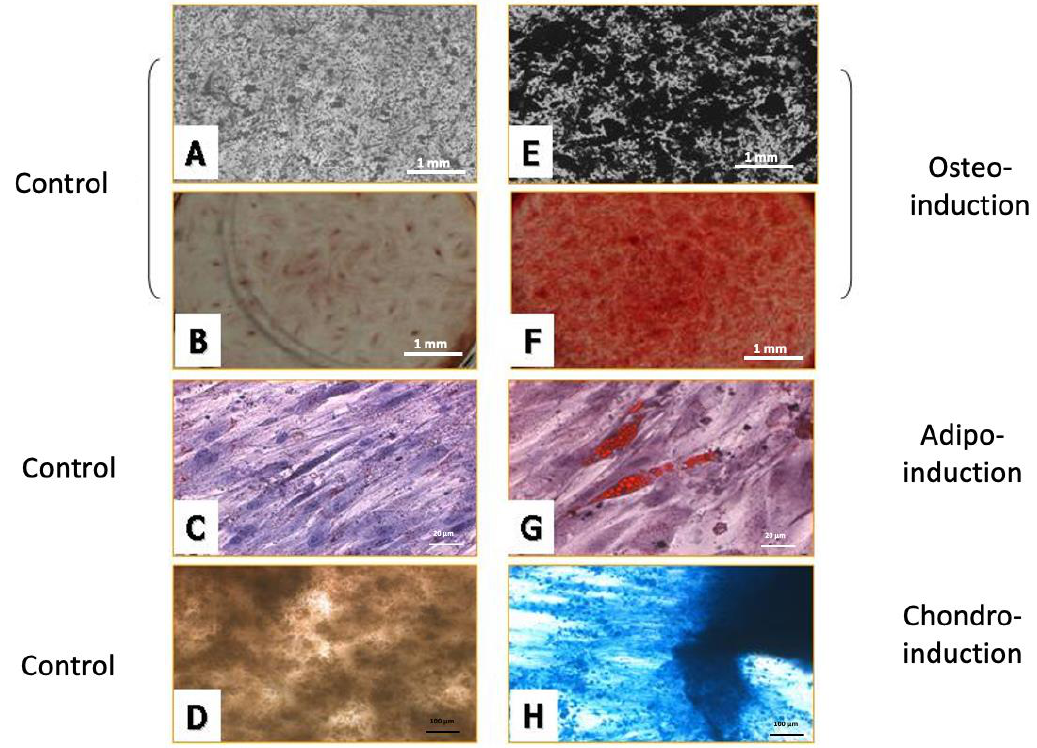
Figure 4. Induction of multilineage stem cell differentiation. Calcification appears as black regions within the cell monolayer in von Kossa stain ( A , E ) and red in alizarin S stain ( B , F ). Cells develop triglycerol-containing droplets that accumulate the lipid dye Oil Red–O in every passage ( C , G ). The cells cultured in the induction showed extensive chondrogenic differentiation while cells cultured in the DMEM showed no chondrogenic differentiation ( D , H ).